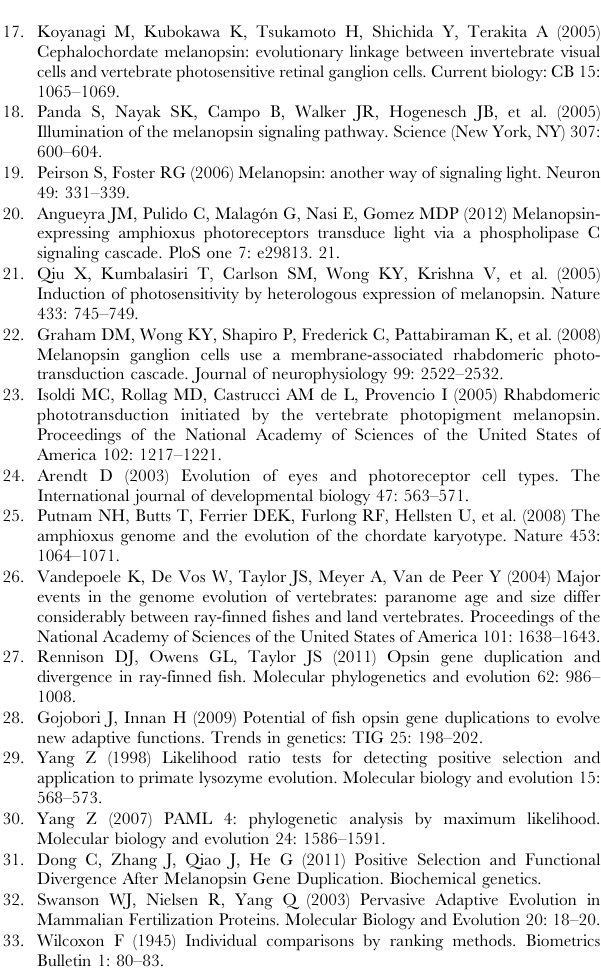
Figure S1 Melanopsin gene tree including the lamprey blasted sequence EN- SPMAG00000006406. ML and Bayesian method were per- Table S4 Nucleotide substitution models and the re- formed to build the phylogenetic tree. Bootstrap and posterior spective estimated parameters for OPN4m, OPN4x and probability support values are respectively represented for each OPN4 alignments. Parameters: base frequencies, substitution node. ratio between the nucleotide bases ( r ), gamma shape parameter and proportion of invariable sites ( p -inv). The comparison between Figure S2 Comparative importance of destabilizing the saturation index (I SS ) and the critical index value (I SS.C ) positive selected substitutions in the OPN4m and OPN4x implemented by Xia et al. 2003 [80] were also represented, as well paralogs for each amino acid property. as the respective category of data Table S1 Melanopsin sequences used in the phyloge- netic analysis. Table S2 Number and relative frequency of the desta- bilizing positively selected substitutions in the OPN4m and the OPN4x paralogs. 30 physicochemical properties were analysed in two categories, based on their nature: chemical and structural. Table S3 Branch and branch-site selection tests and the respective estimated parameters. The asterisk (*) means